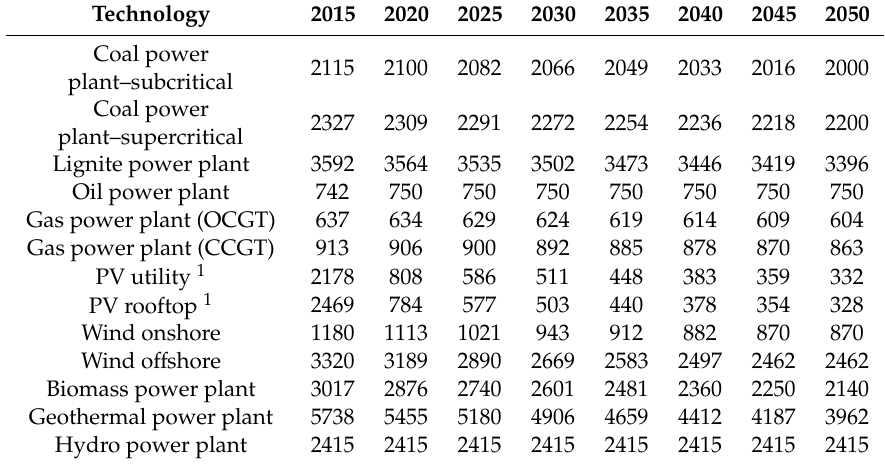
Table A2. Investment costs of power plant technologies (all costs are in US $2018 / kW). Data based on References